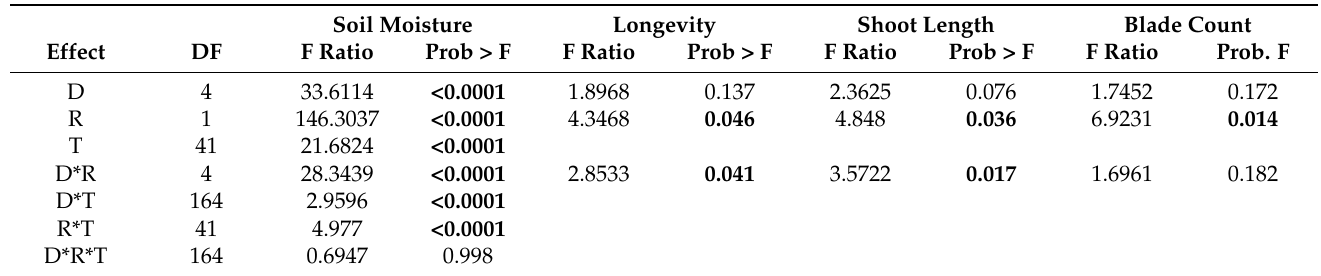
Table 3. Statistical results of a glass house study evaluating the effect of SAP depth (D), rate (R), time (T), and their interactions on soil moisture, seedling longevity, shoot length, and blade count. Bolded numbers indicate p < 0.05.